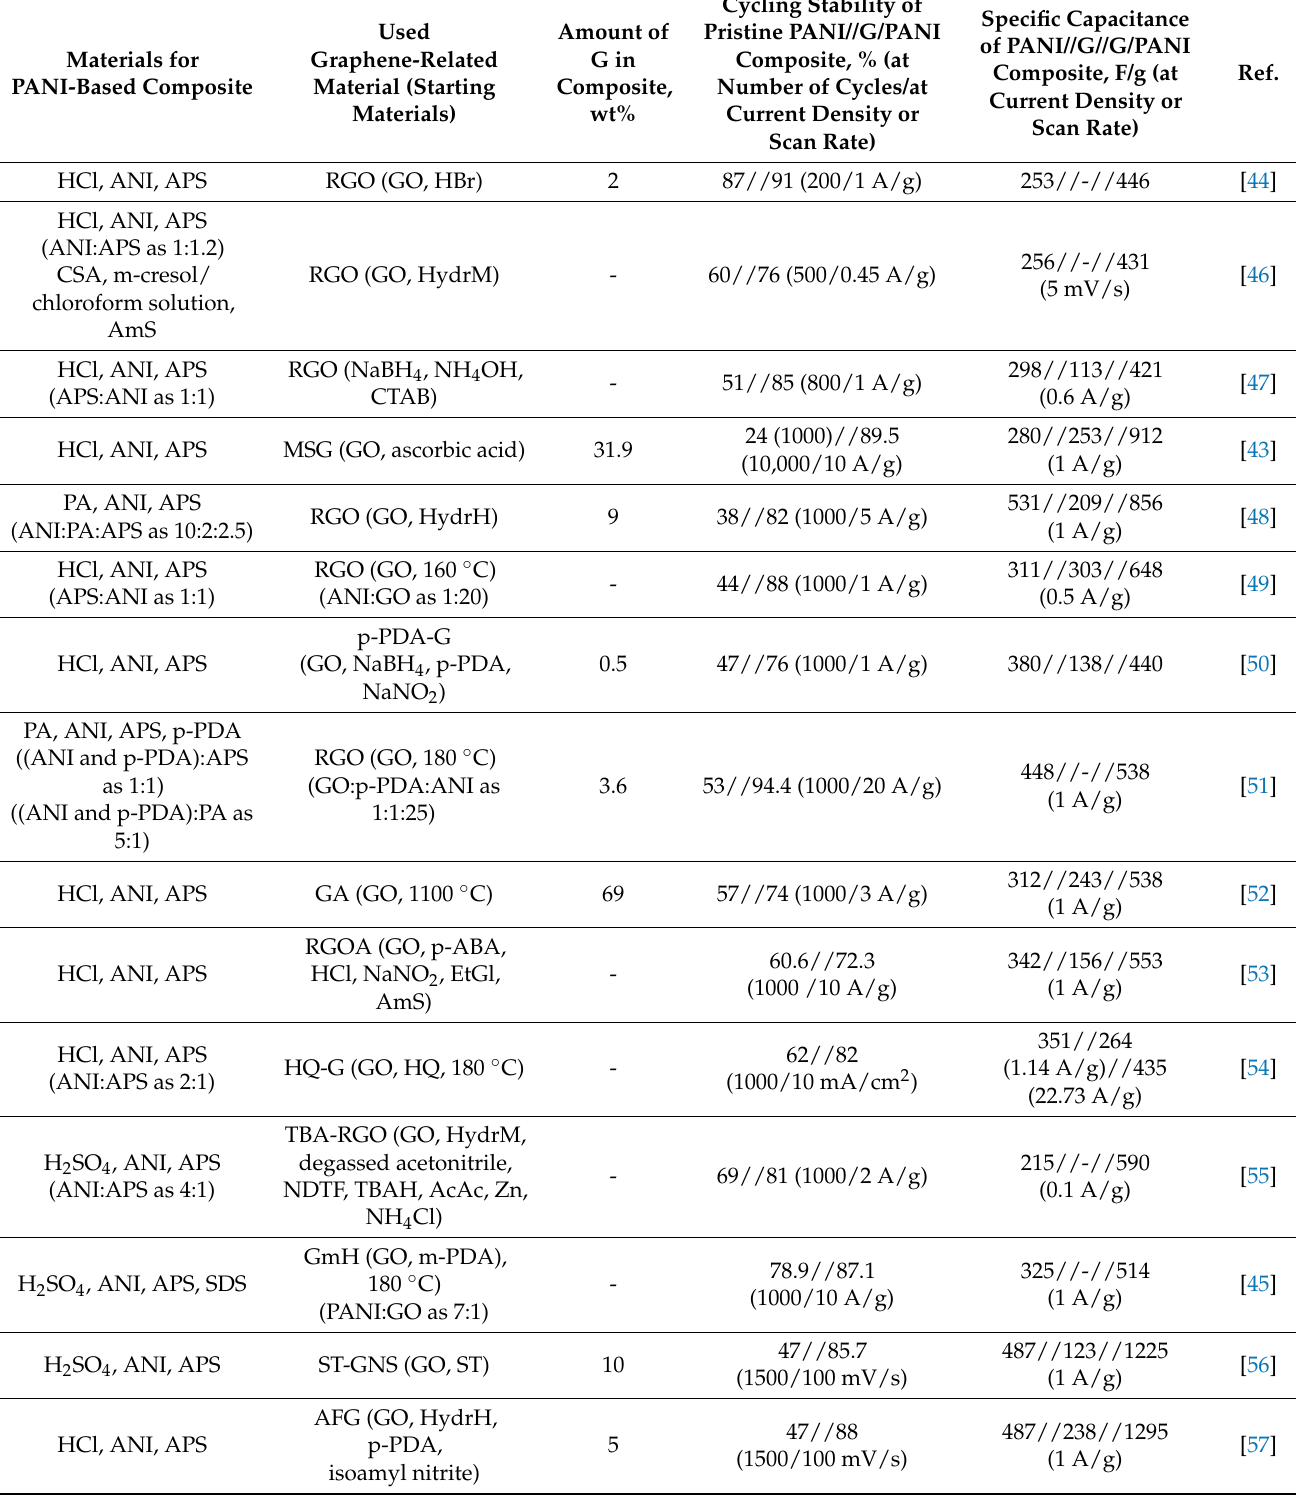
Table 1. Literature data of the cycling stability and specific capacitance measured in three-electrode systems for PANI and graphene-related components separately and in composites (ordered by num- ber of cycles of cycling stability). Meaning of the abbreviations can be found in the text or glossary.